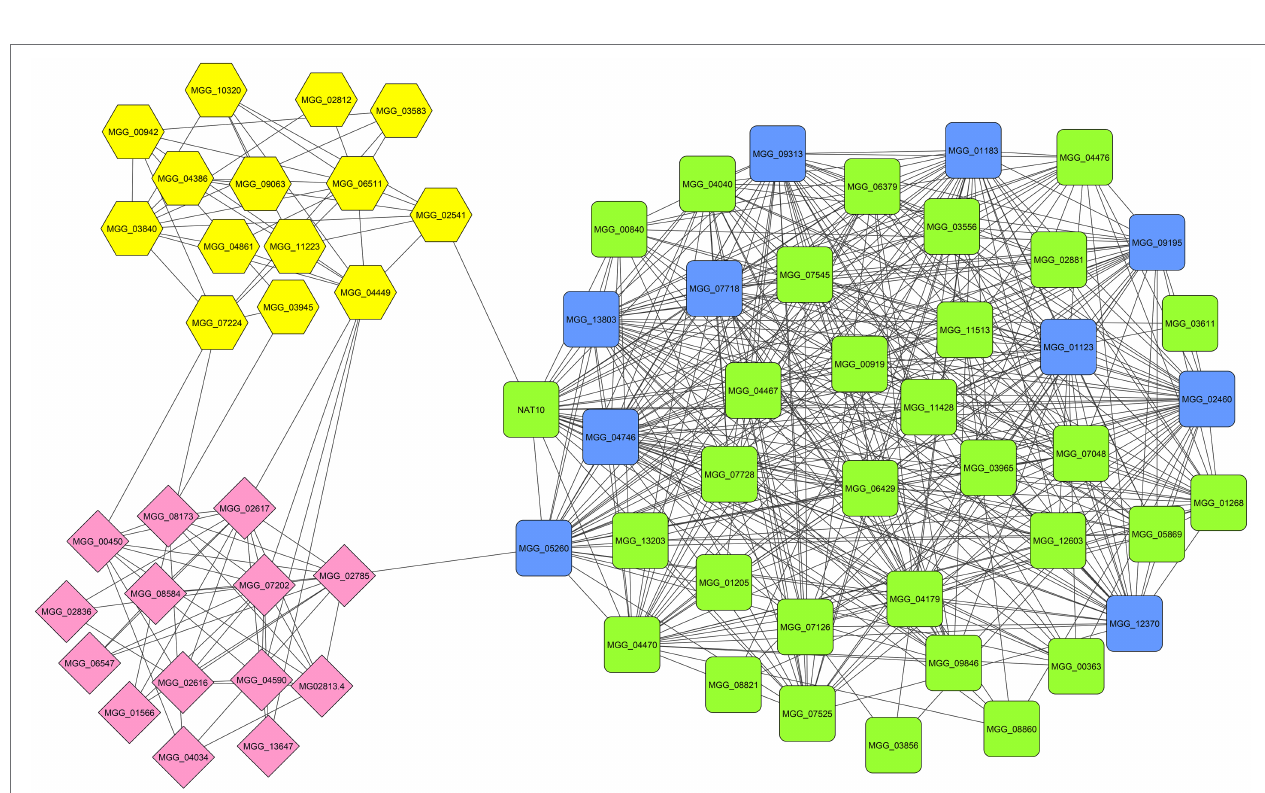
FIGURE 6 | The significant modules (green, yellow, and pink) and identified hub genes (blue) associated with down-regulated DEGs of M. grisea fungi in response to ZnO